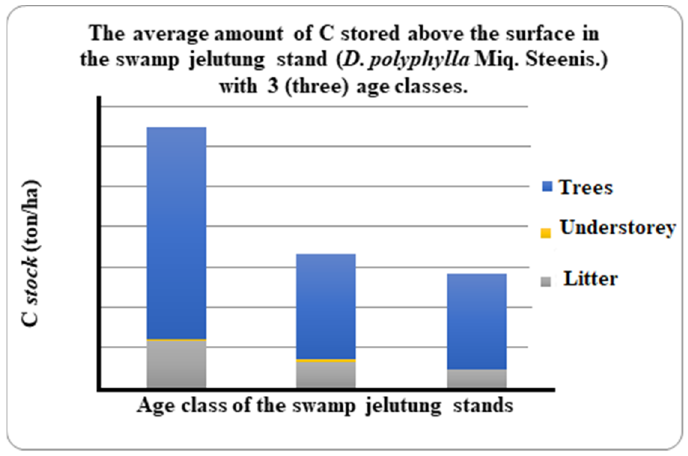
Figure 4. The average amount of C stored in each constituent. the component aboveground in D. polyphylla stands in three age classes. Table 6. One-way ANOVA analysis results for the average amounts stored in D. polyphylla trees for thre age classes.